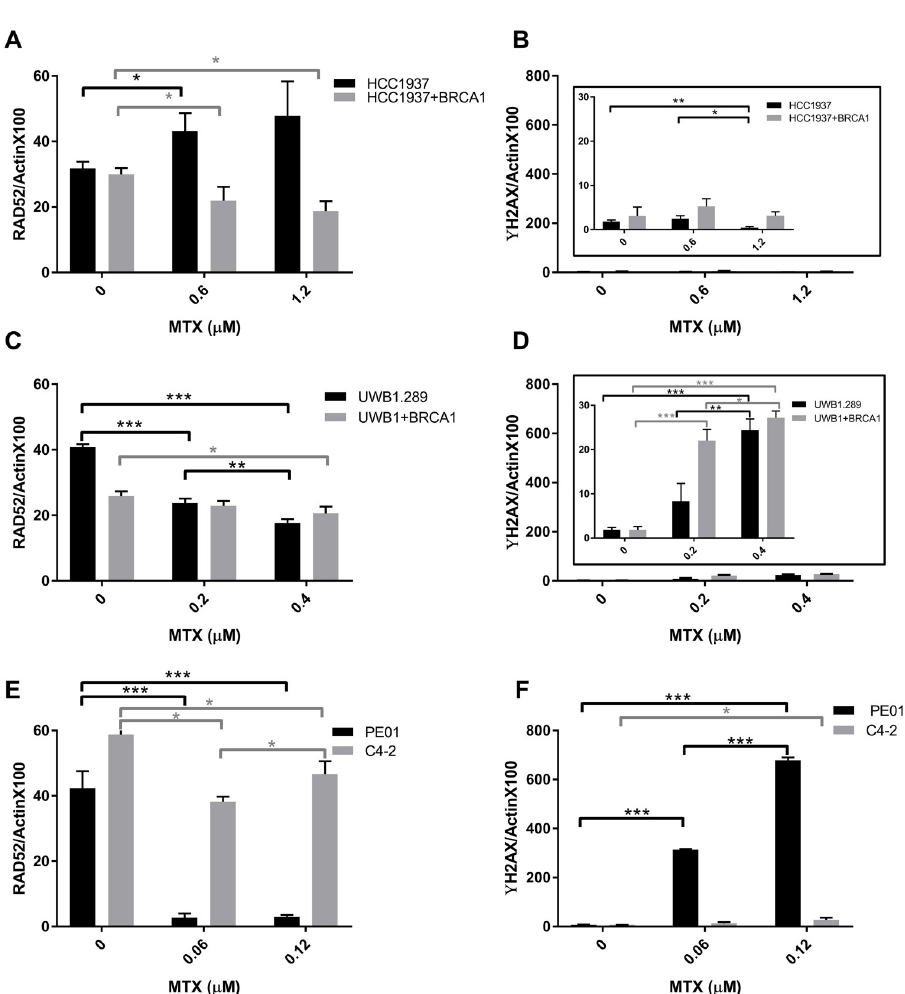
Fig 6. The effect of mitoxantrone treatment on RAD52 levels and DNA damage. (A, C, and E) RAD52 and γ H2AX (B, D, and F) levels were probed in the three parental (black) and (BRCA1 or BRCA2 proficient, grey) cell lines indicated was assessed with Simple Western using lysate post 72 h treatment with mitoxantrone at doses near their EC 50 values (see Figs 2–4). Data and ANOVA statistical analyses are described in the material and methods section. Significance statistics are shown with single, double, or triple asterisks representing P < 0.05, P < 0.005, or P < 0.0005,